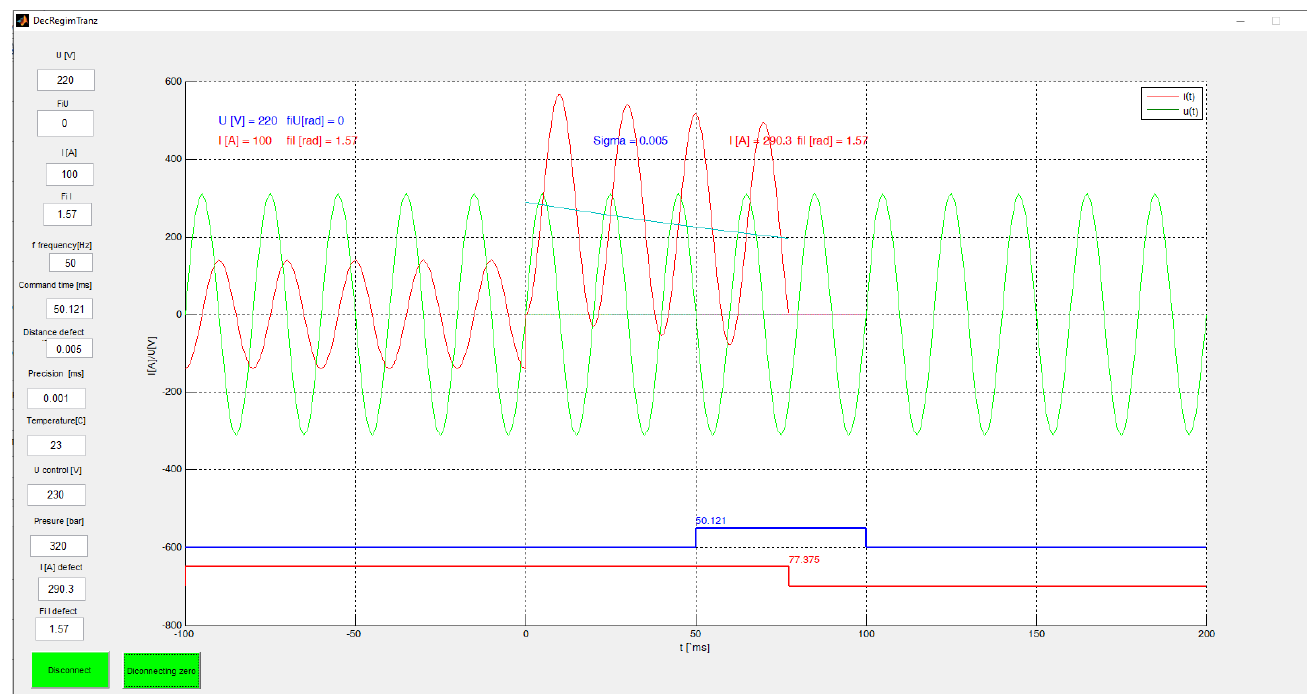
Figure 17. Transient switching diagram for inductive load, ɸ Idef = π /2, Idef = 290.3 A, σ = 0.005, t command = 50.121 ms, t disconnect = 77.375 ms.